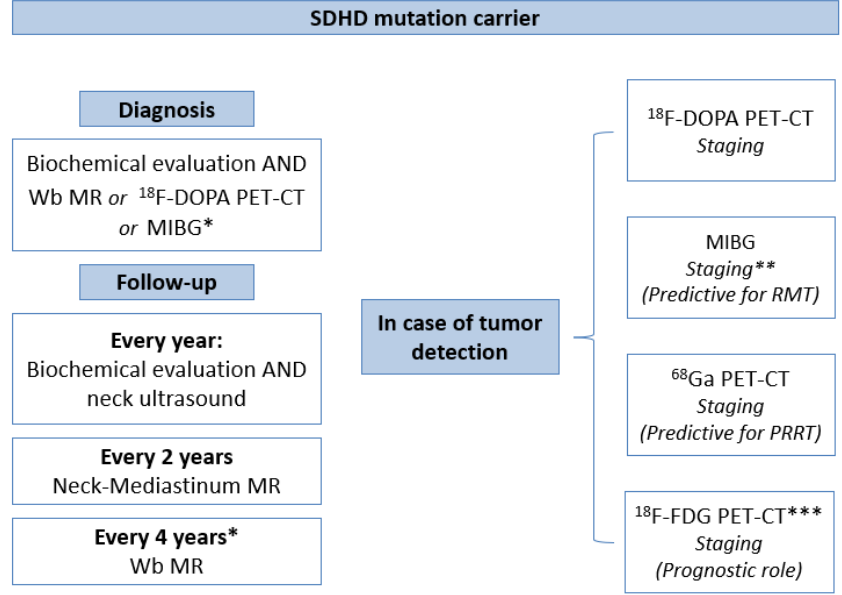
Figure 4. Proposed diagnostic algorithm; * Or in case of suspected symptoms of extra head / neck / mediastinum tumors; ** If DOPA not available; *** To define biological aggressiveness and metastatic potential. Abbreviations: Wb = whole body; MR = magnetic resonance; DOPA = 3,4- dihydroxyphenylalanine; PET = positron emission tomography; CT = computed tomography; MIBG = metaiodobenzylguanidine; RMT = radioactive microsphere therapy; PRRT = peptide receptor radionuclide therapy; FDG = fluoro-2-deoxy-D-glucose.